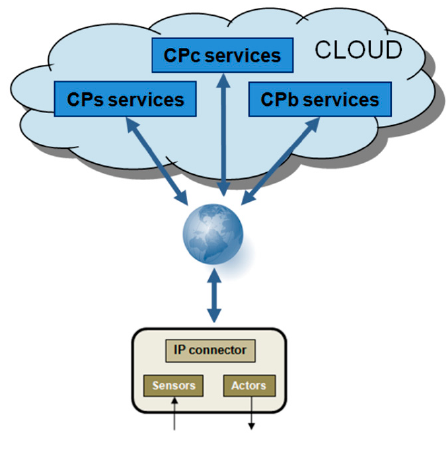
Figure 3. C33 Figure 3. C33 controller.